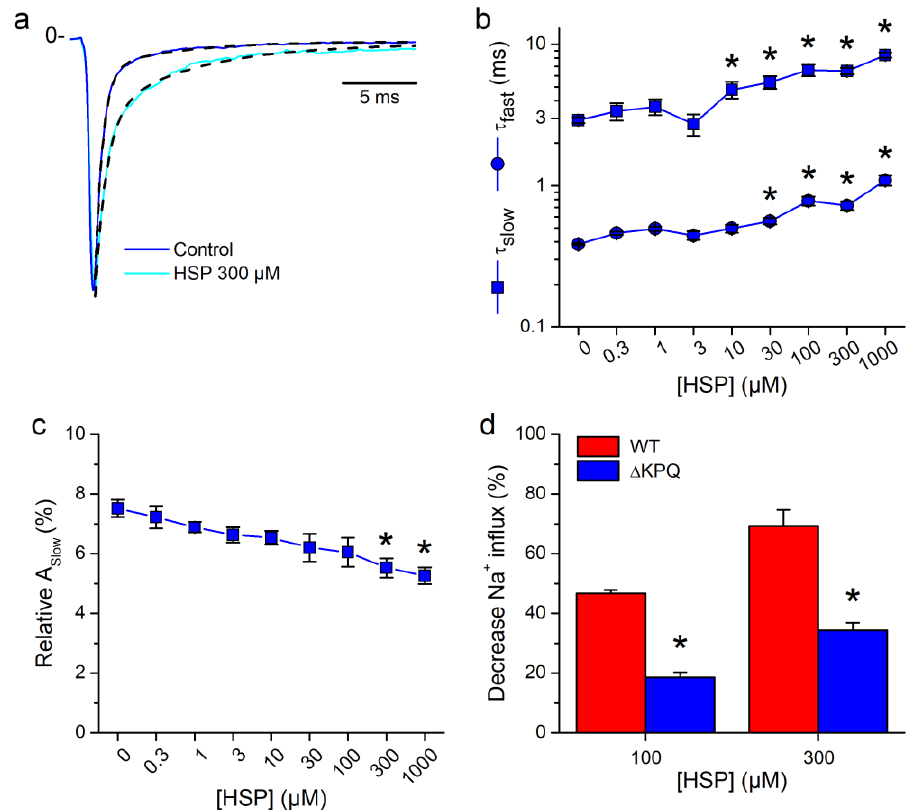
Figure 3. Hesperetin decreases the inactivation rate of LQT3 ∆ KPQ mutant currents. ( a ) Superimposed ∆KPQ hNa V 1.5 currents in the control and in the presence of HSP 300 µM. Note that HSP decreases inactivation rates. The dotted lines represent bi-exponential fittings of current traces. ( b ) Effects of different concentrations of HSP on inactivation time constants of I Na in the ∆KPQ hNa V 1.5 channels. * p < 0.05 compared to its own control; n = 21, one-way ANOVA with Tukey’s post hoc test. ( c ) HSP barely decreased the amplitude of the slow component of I Na inactivation (A slow ). A significant ( p < 0.05) reduction was only achieved at the highest concentrations. ( d ) The decrease in Na + influx by HSP is more marked in WT hNa V 1.5 channels. Columns are the mean ( ± s.e.m.) percent decreases in Na + influx by HSP with respect to control values. HSP discreetly reduced the amount of Na + influx during the flow of I Na , in hNa V 1.5 channels carrying the ∆KPQ mutation.